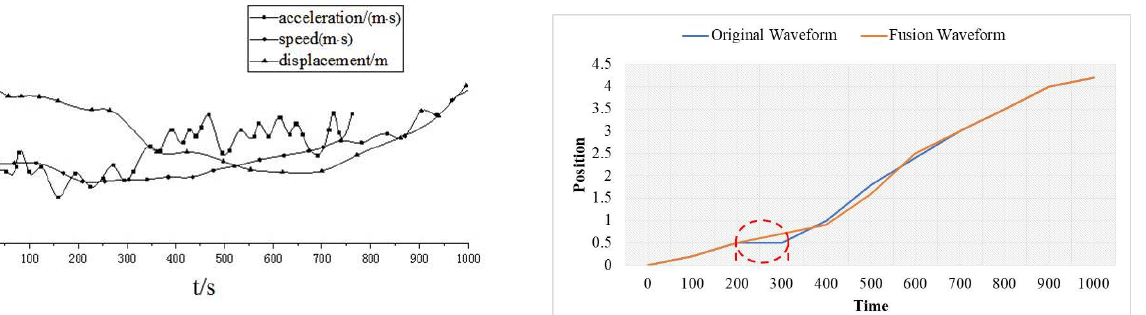
Figure 10: Simulation results of the system under filtering